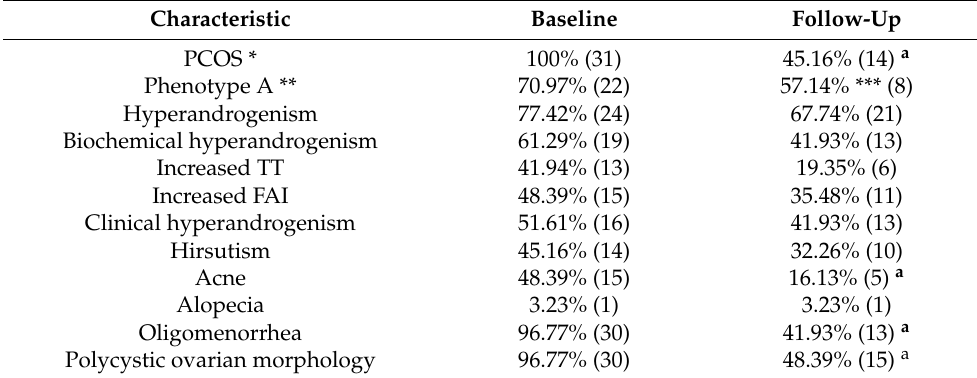
Table 1. Prevalence of major PCOS features at the beginning and at the end of the follow-up ( n = 31). Characteristic